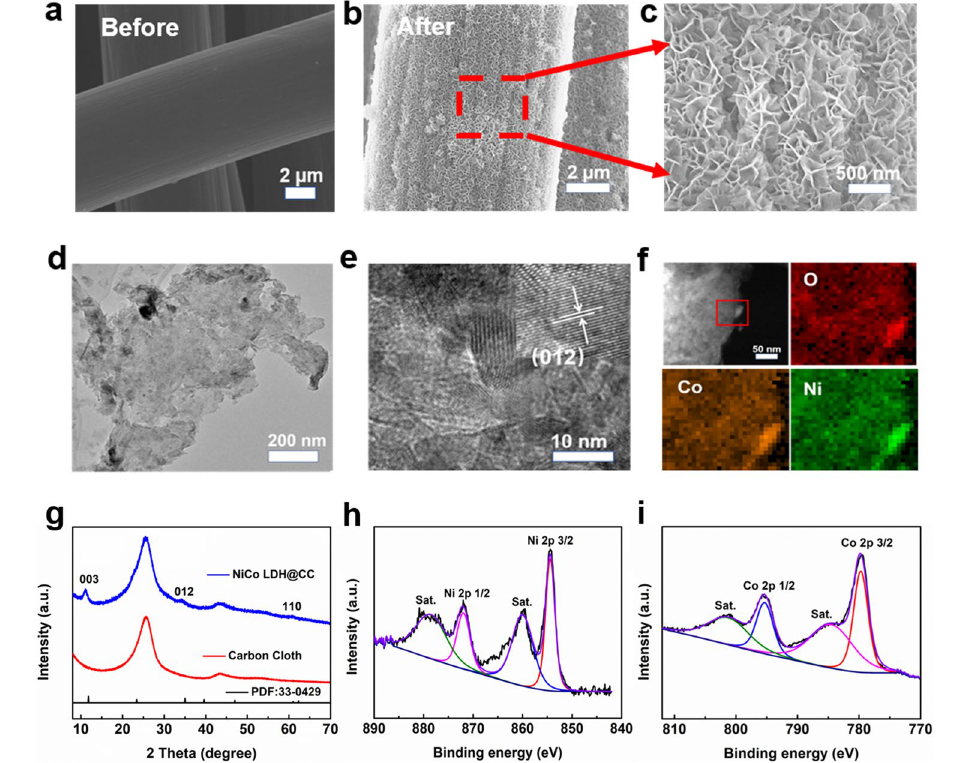
Fig. 2 a–c SEM images of primary CC and NiCo LDH@CC. d–f TEM, element mapping and HRTEM images of NiCo LDH. g XRD patterns of treated carbon cloth and NiCo LDH@CC. h–i High-resolution XPS spectra of Ni 2 p and Co 2